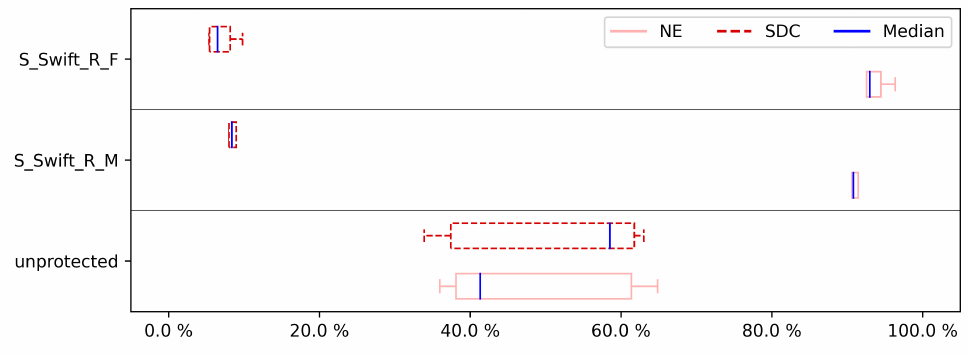
Figure 8. DFE fault injection results for 3 registers.